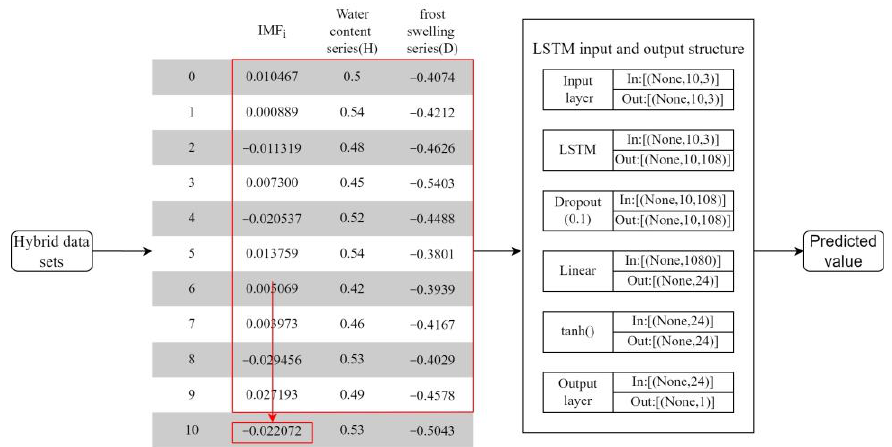
Figure 7. Flow chart of the experiment.